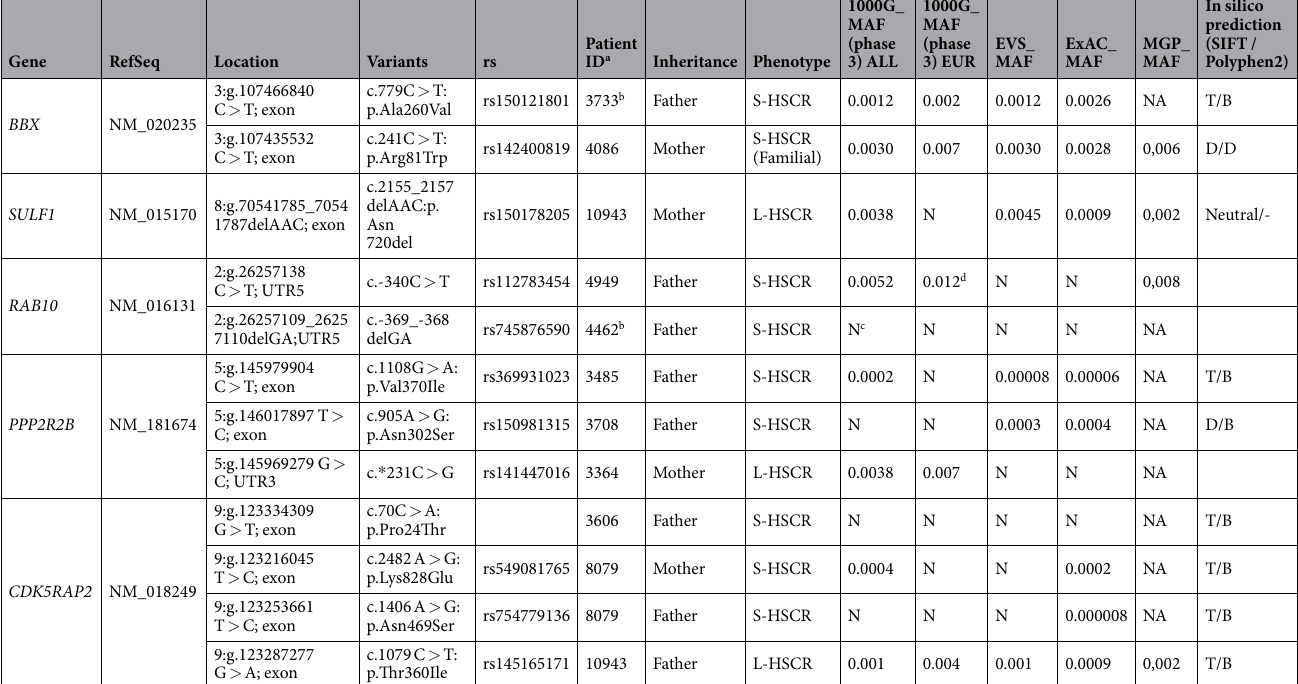
Table 4. Rare variants identificated in exome sequencing from HSCR patients. a patients with two different variants are in bold. b Variants also present in one sibling. c N means variant not present in the database (1000 Genomes, EVS, ExAC). d MAF > 0.01 in European population. NA: Not